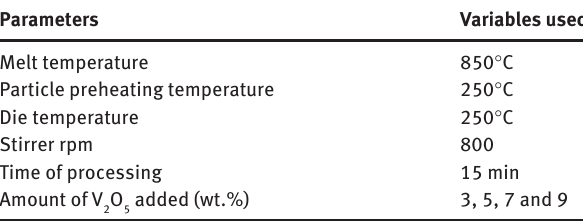
Table 1: Process parameters